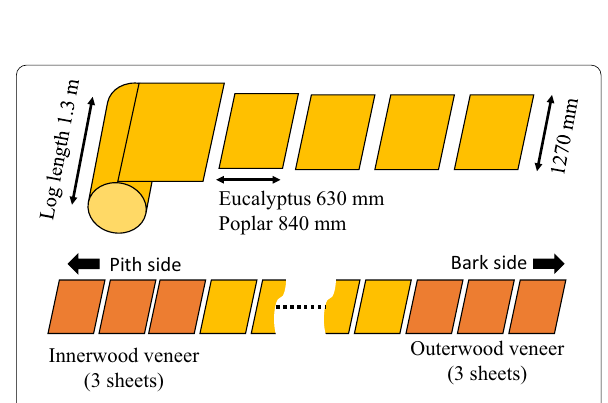
Fig. 2 Lathe process of eucalyptus and poplar log, and selection